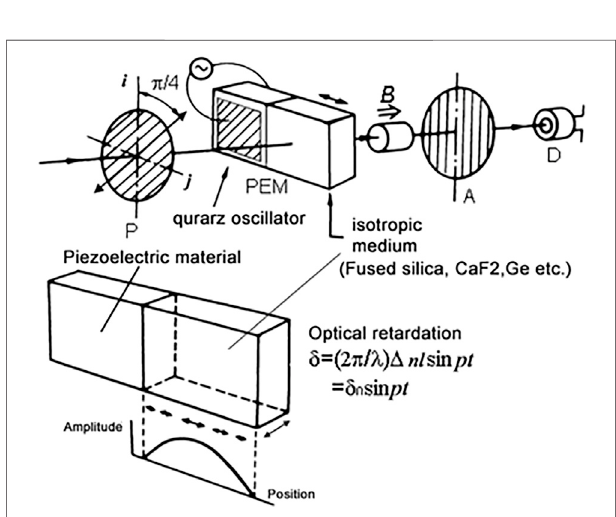
FIGURE 11 | Optical retardation modulation